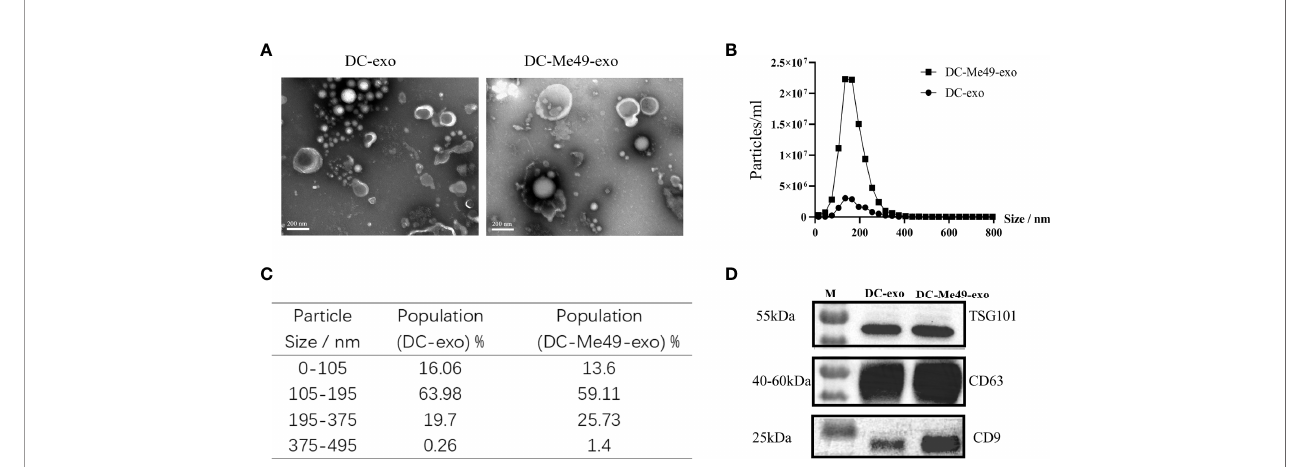
FIGURE 2 | Isolation and characterization of exosomes. (A) Exosomes were stained with uranyl acetate and analyzed three times via TEM (original magni fi cation, × 100,000; scale bar = 200 nm). (B) Nanoparticle-tracking analysis of size distribution of puri fi ed exosomes. (C) Percentages of puri fi ed exosomes in various size